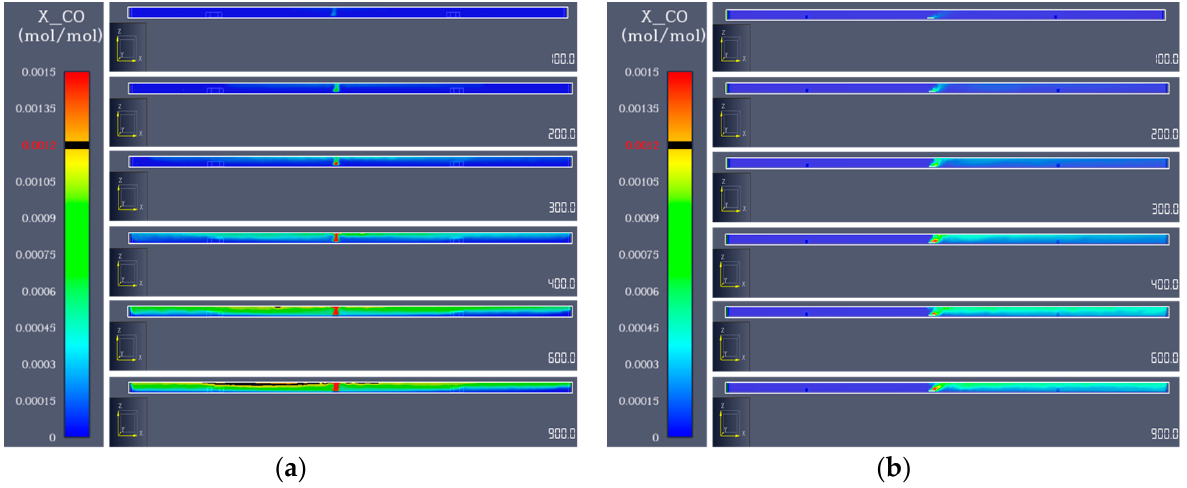
Figure 8. Changes in the longitudinal center section of the CO concentration: ( a ) 0.5 m/s; ( b ) 3.6 m/s. Under a 0.5 m/s longitudinal ventilation velocity, as the distance from the fi re source increased, the CO concentration also changed. A longer underground interchange may